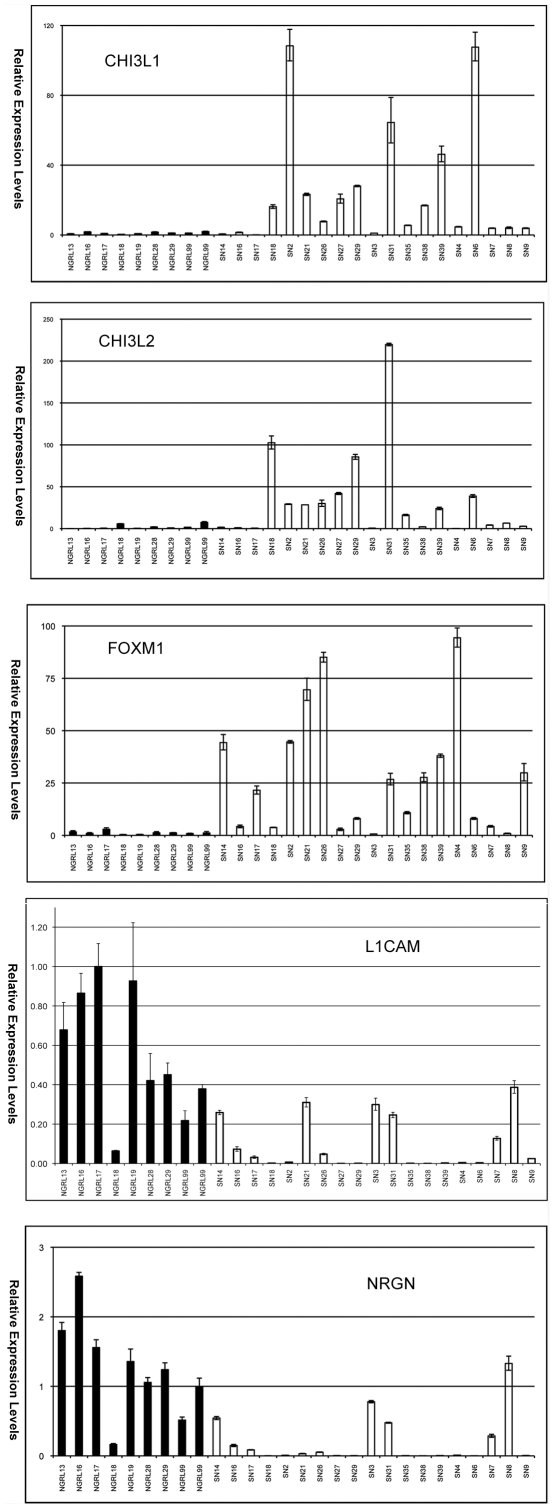
Bar charts showing the quantitative RT-PCR results of CHI3L1, CHI3L2, FOXM1, NRGN and L1CAM on a panel of 19 individual brain tumor samples (SN series) and 9 individual normal brain tissue samples (NGRL series).Black bars, NGRL series (normal) samples; white, SN series (GBM) samples. Y-axis indicates relative expression levels and X-axis indicates individual samples. Three replicate PCR were performed and the standard errors of the mean were indicated by error bars.